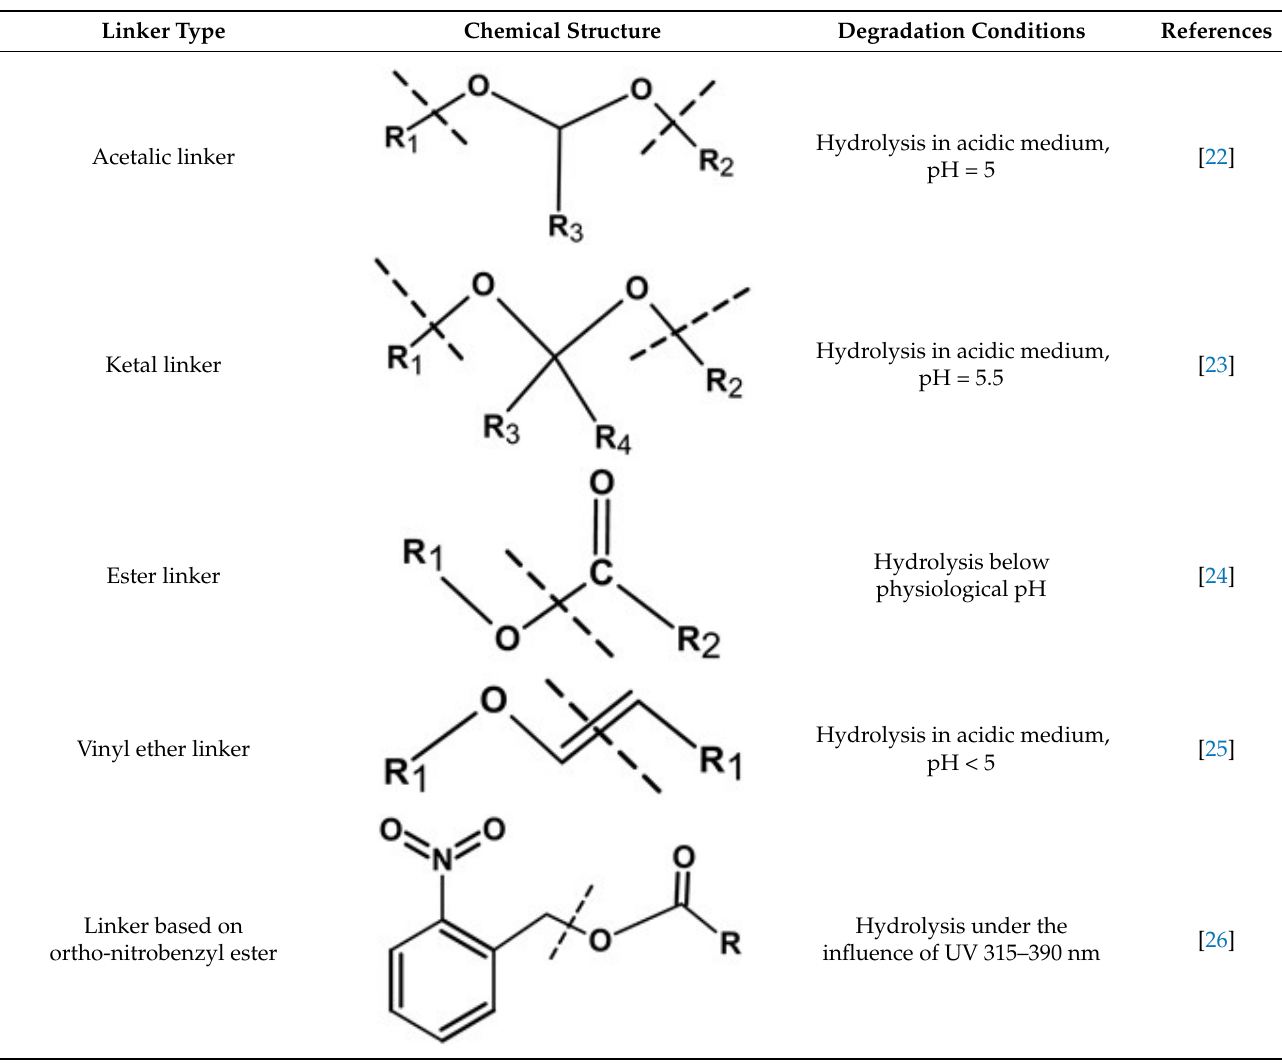
Table 1. Describing different labile bonds present in hydrogels, including their functional groups and chemical structures, for the release of therapeutic agents. Adapted with permission from [20]; Published by MDPI, 2019.